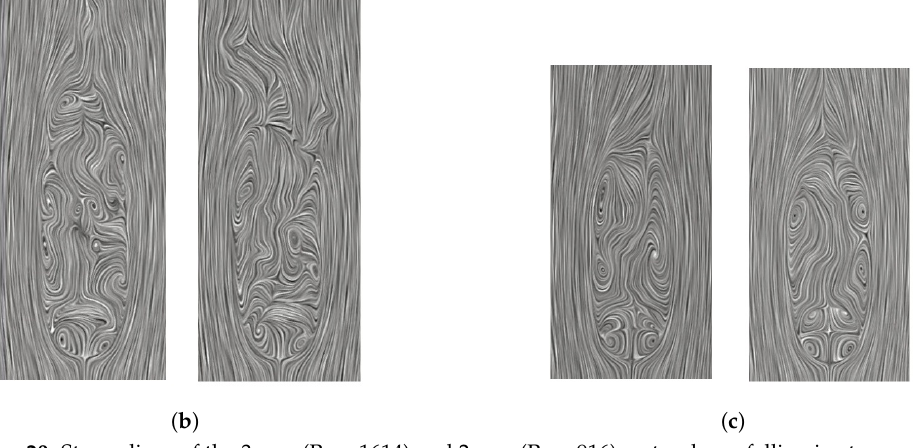
Figure 20. Streamlines of the 3 mm (Re = 1614) and 2 mm (Re = 916) water drops falling in stagnant air at their terminal velocities: ( a ) Time-averaged streamlines of the 3 mm (left) and 2 mm (right) water drop. ( b ) Streamlines of the 3 mm water drop at two different time steps. ( c ) Streamlines of the 2 mm water drop at two different time